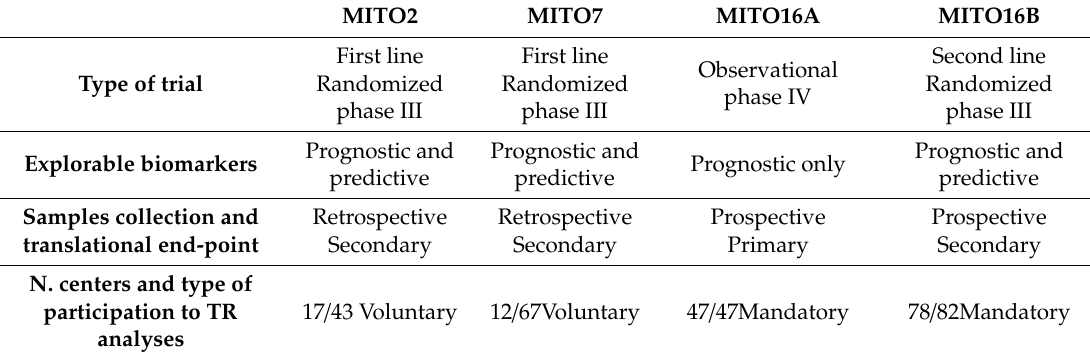
Table 1. Selected MITO Clinical trials with translational